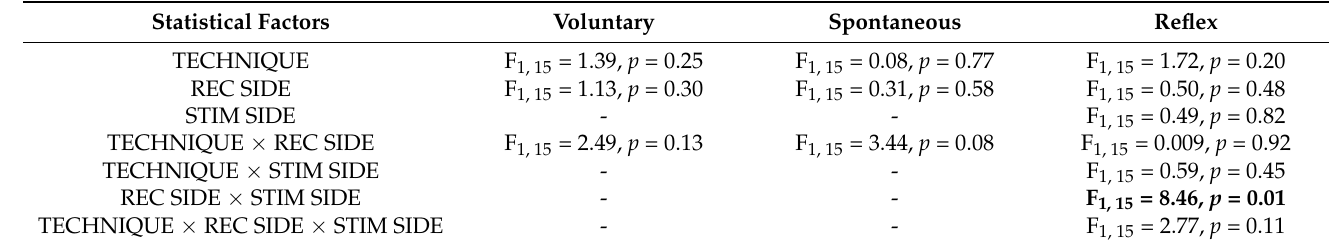
Table 2. Statistical analysis for the orbicularis oculi muscle electromyographic recordings. The table shows the statistical output from the rmANOVA performed on the electromyographic data during voluntary, spontaneous and reflex blinking. REC SIDE: recording side; STIM SIDE: stimulation side. Significant factors and interactions are depicted in